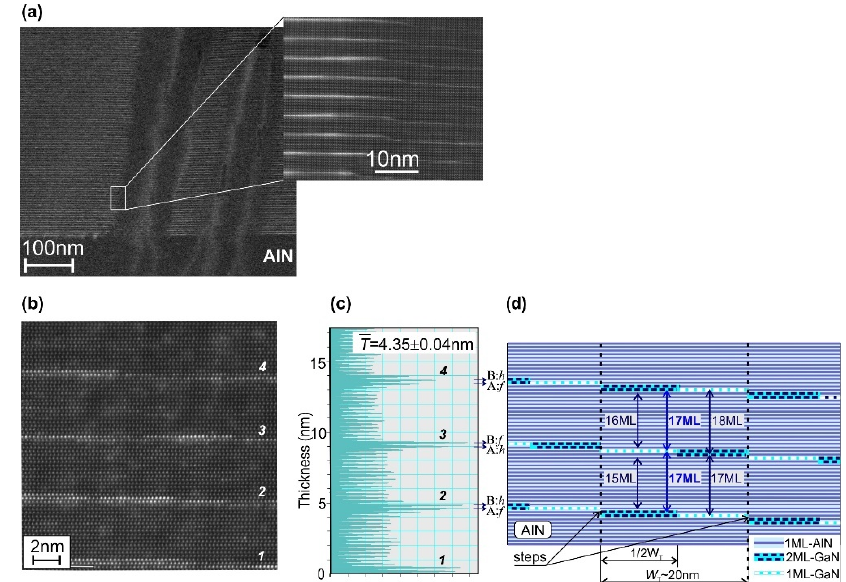
Figure 6. HAADF STEM images of N × {GaN 1.5 /AlN 16 } MQW structures with: N = 400 ( a ); 100 ( b ) taken at different magnifications. ( c ) Integrated distribution of brightness in image ( b ). ( d ) Schematic illustration of the stepped pattern of the MQW structure with m = 1.5 ML.